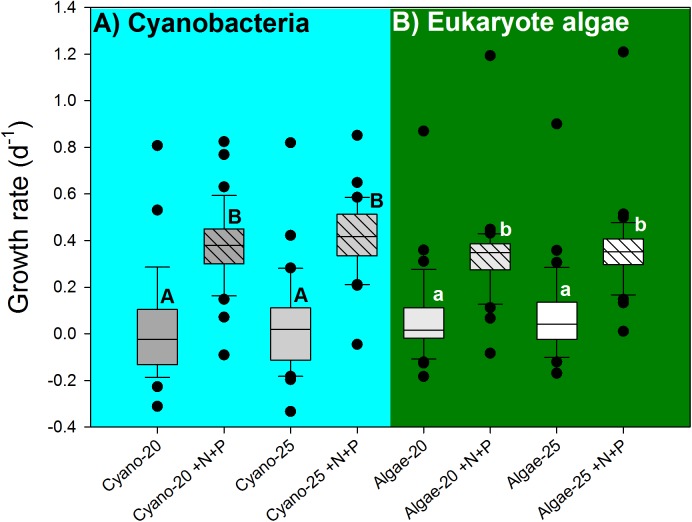
Cyanobacterial growth rates (A), based on chlorophyll-a concentrations (μg l−1) and eukaryote algae growth rates (B) in water samples from 39 urban ponds and lakes incubated for 7 days at 20°C or 25°C without extra nutrients or with a pulse of N and P (+N+P). The boxes indicate the 25th – 75th percentiles, the line the median, the whiskers the 10th and 90th percentile and the dots each outlier. Similar letters (A,B for cyanobacteria and a,b for eukaryote algae) indicate homogeneous groups that are not different from each other.